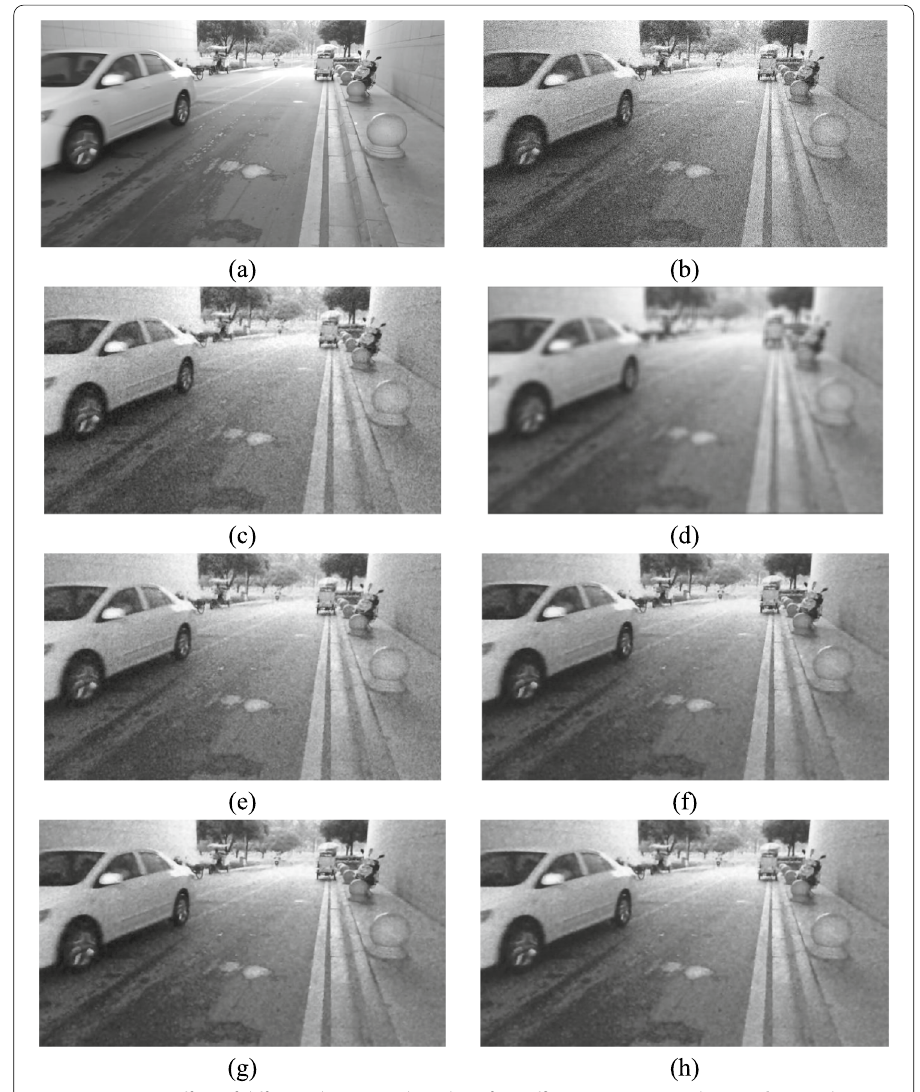
Fig. 9 Denoising effect of different denoising algorithms for traffic images: a original image, b noised image, c Median filtering result, d Neighborhood average filtering result, e Wiener filtering result, f BP result, g WOA-BP result, h MSWOA-BP